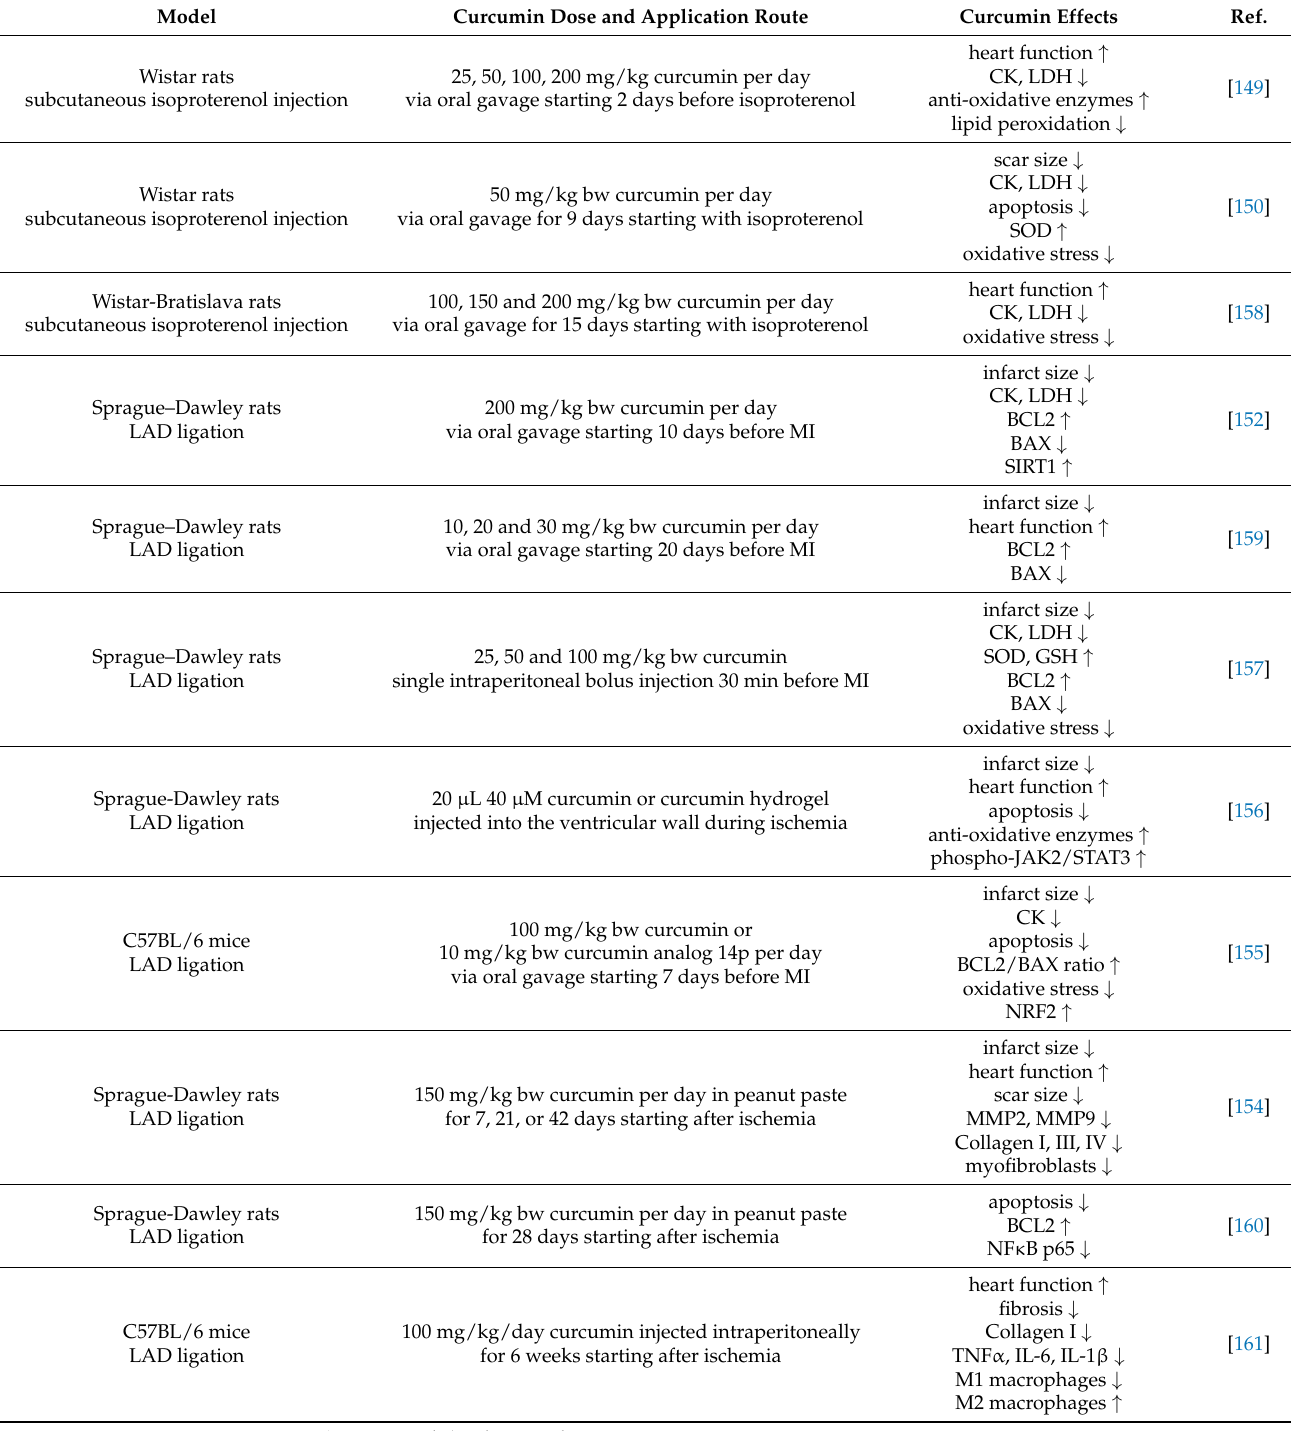
Table 2. Curcumin effects in animal models for myocardial infarction. Only models in which I/R was performed in vivo are